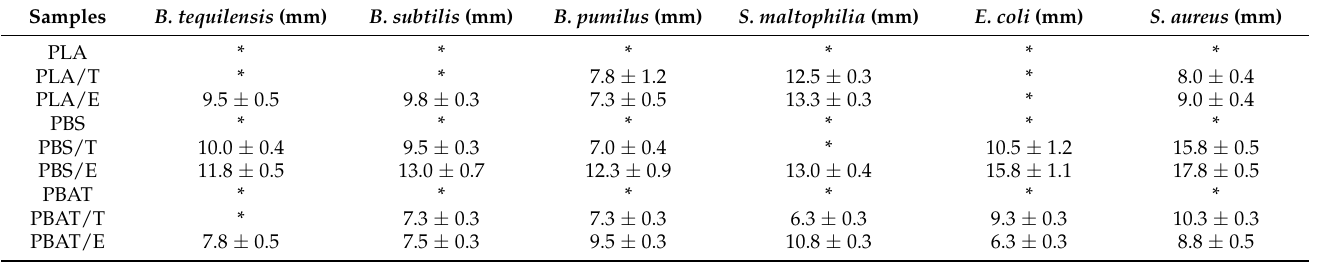
Table 10. Antibacterial activity is determined using the disk diffusion method (sample 5 mm in diameter)